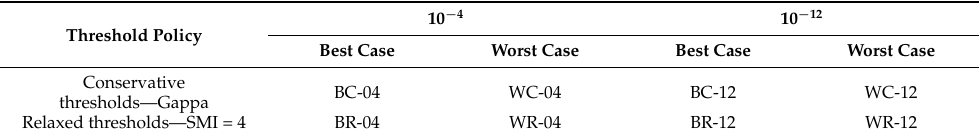
Table 2. Worst cases’ and best cases’ nomenclature per tolerance threshold and threshold generation policy—Jacobi.